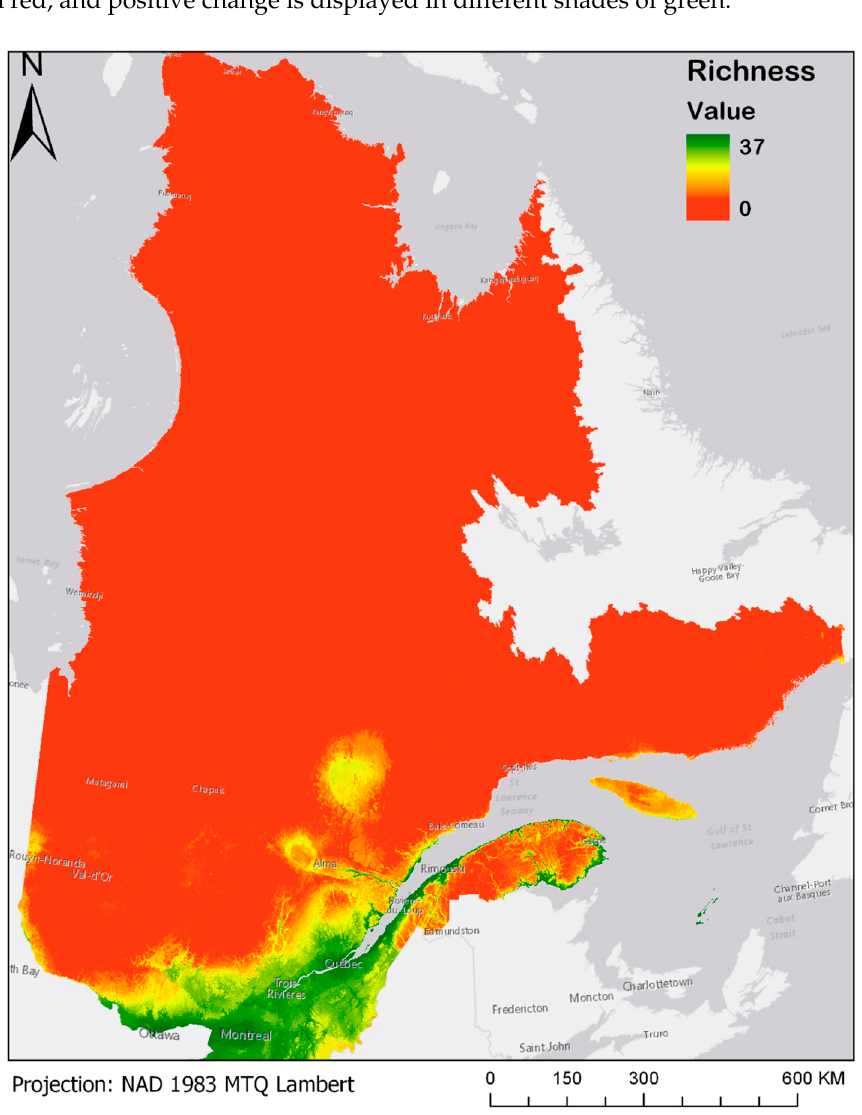
Figure 3. Current (1980–2013) modeled bird species richness for the Boreal forest of Quebec. Please see Supplementary Materials for the online version of the map.